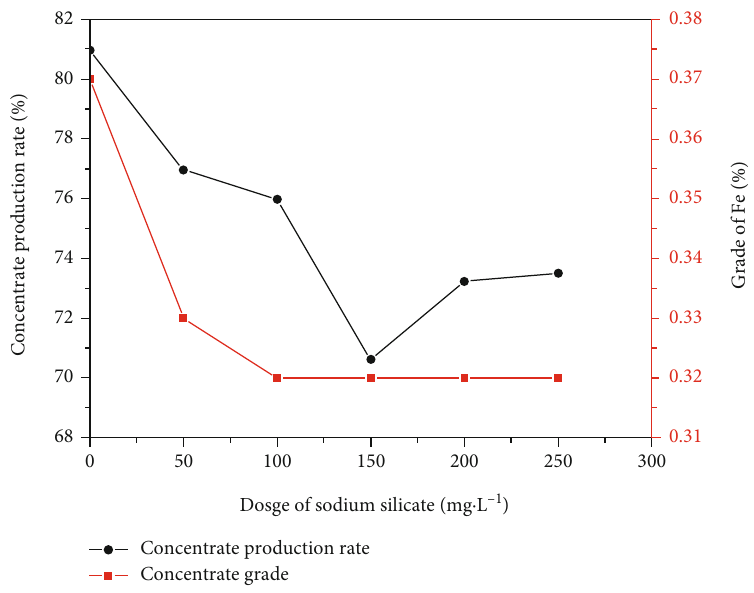
Figure 6: E ff ect of sodium silicate on arti fi cial mixed-ore test